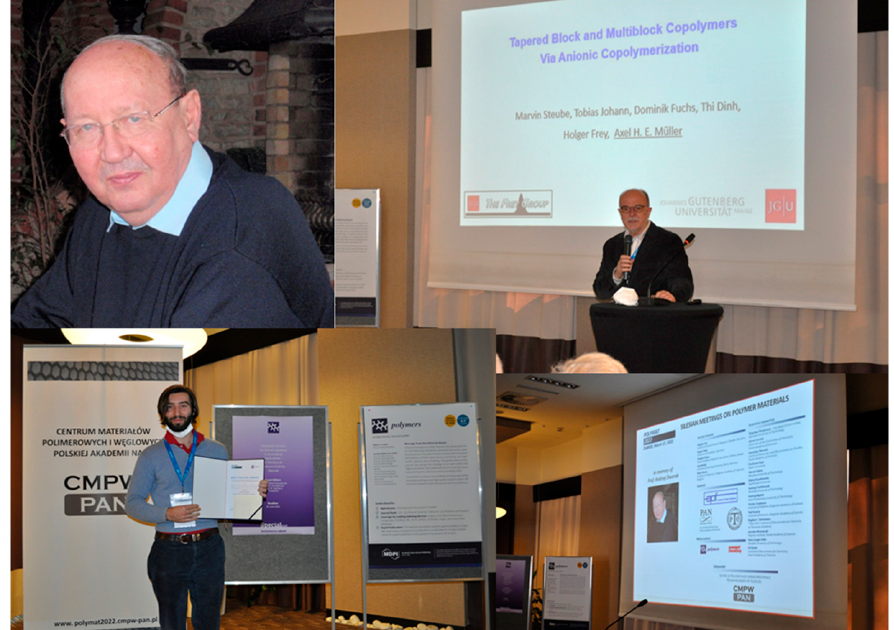
Figure 2. POLYMAT 2022 Conference in memory of Prof. Andrzej Dworak (photo by CMPW PAN). Top row: Prof. Andrzej Dworak; Prof. Axel Müller giving a lecture. Bo tt om row: Ma tt ia Parati, University of Wolverhampton, United Kingdom, receiving the award for the best poster.